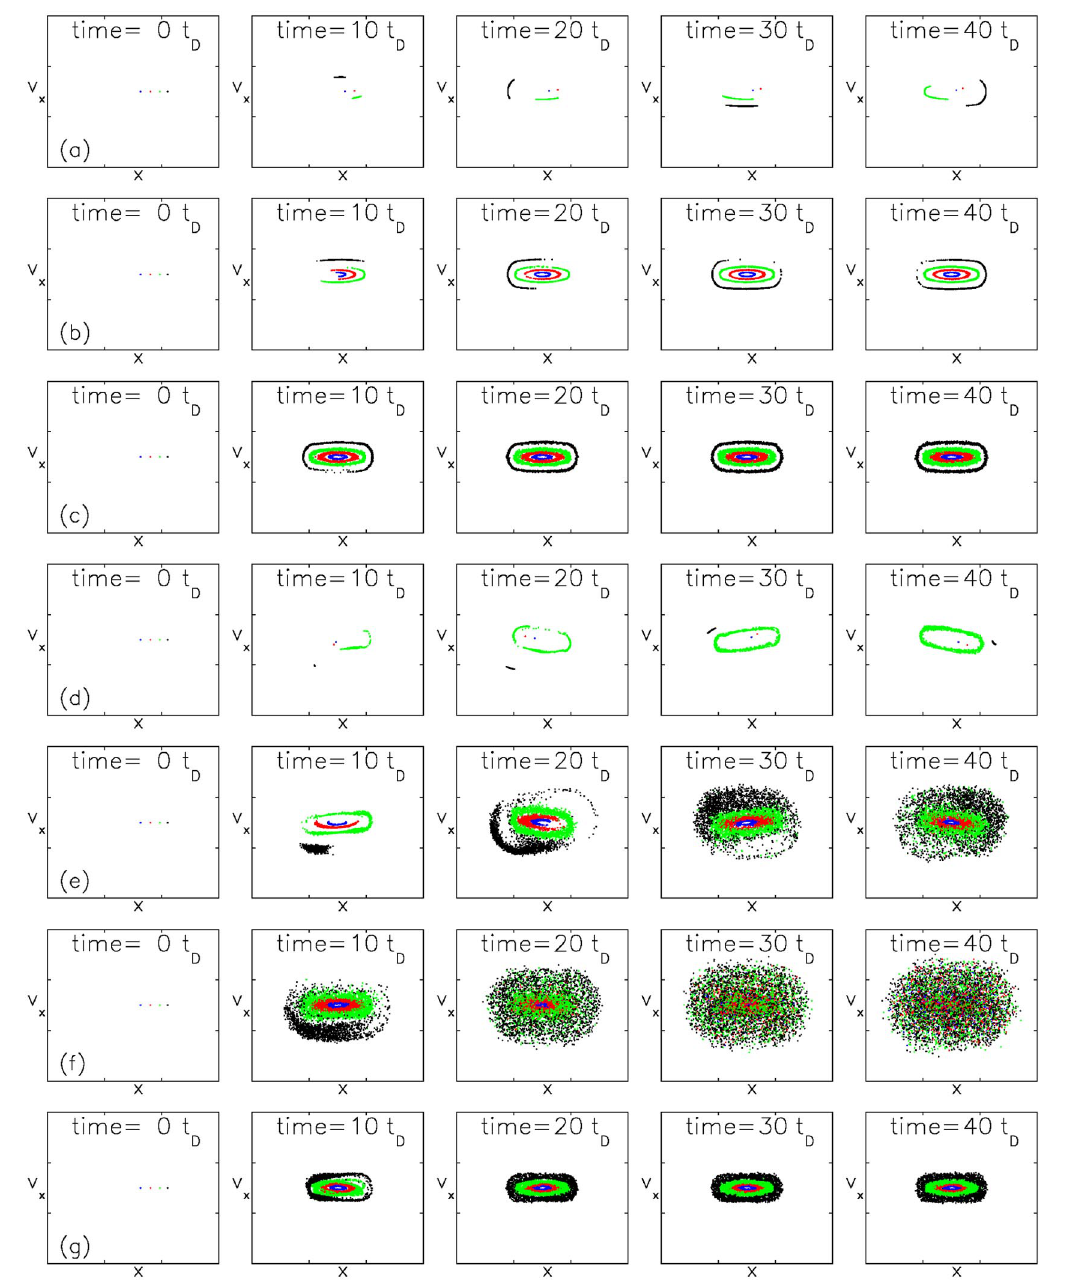
(cid:2) 80 , (cid:13) (cid:2) 0 , and (a) (cid:13) (cid:2) 0 , hj (cid:22)! ji (cid:2) 0 , c 2 1 (cid:2) 0 : 05 , hj (cid:22)! ji (cid:2) 0 , (e) (cid:13) (cid:2) 0 : 05 , hj (cid:22)! ji (cid:2) 0 : 001 , and (f) (cid:13) (cid:2) 0 : 05 , 1 1 1